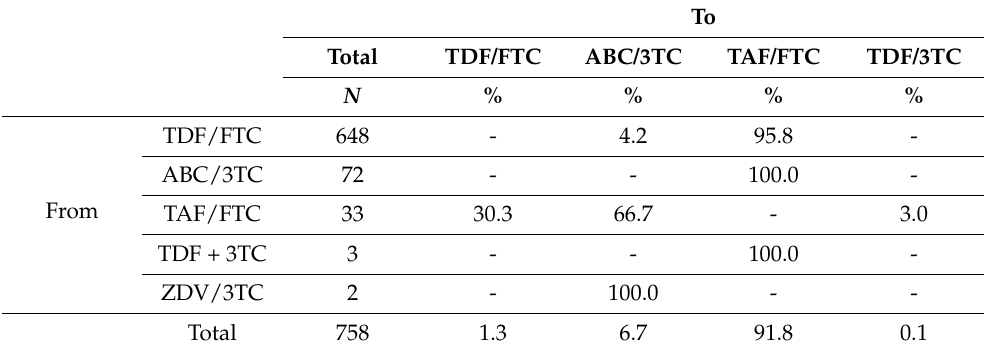
Table 4. Switching matrix for NRTI backbones